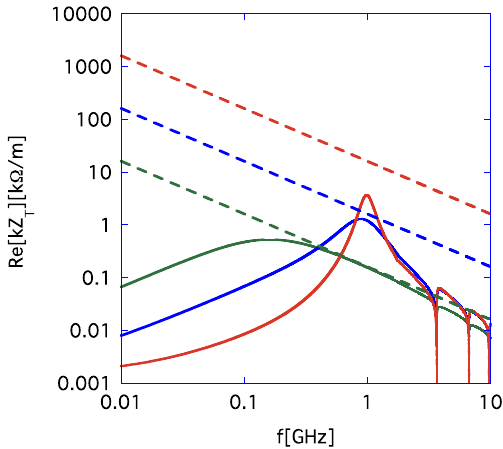
FIG. 9. (Color) The transverse impedances for the case of t (cid:4) t . The green solid and dashed, the blue solid and dashed, and min the red solid and dashed lines show the cases that the thickness of the insert t is equal to 1 nm, 100 pm, and 10 pm, respectively. The solid lines are based on the present theory, while the dashed lines are calculated hypothetically by extending the simple formula (76) to these extreme